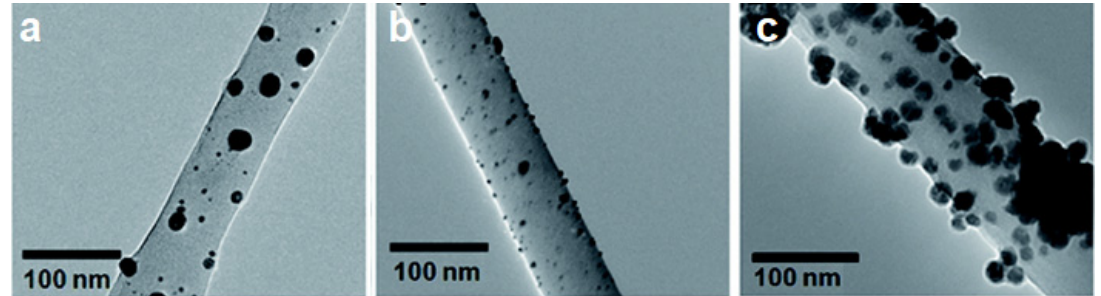
Figure 10. Transmission electron microscope (TEM) image of ( a ) Ag, ( b ) Au, and ( c ) Ni nanoparticles on cellulose nanofiber surface [74]. (Reprinted with permission from Gopiraman et al., 2018.)